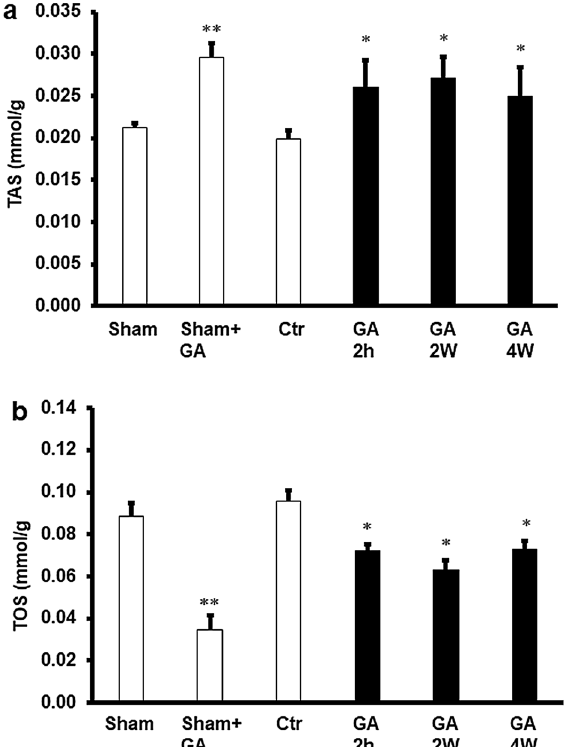
period and before I/R procedure compared to the levels in the control group (n = 4). Ctr control, GA 2 h Gum Arabic infusion 2 h before sacrifice, GA 2 W Gum Arabic administration for 2 weeks, GA 4 W Gum Arabic administration for 4 weeks, GA Rep . Gum Arabic infusion at reperfusion. *P < 0.01 compared to the respective controls and **P < 0.01 compared to controls and vehicle treated